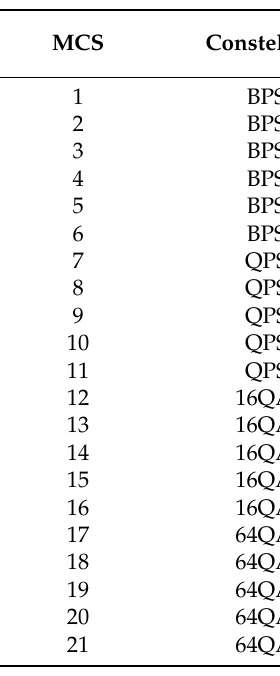
Table 4. SNR values for the spirit